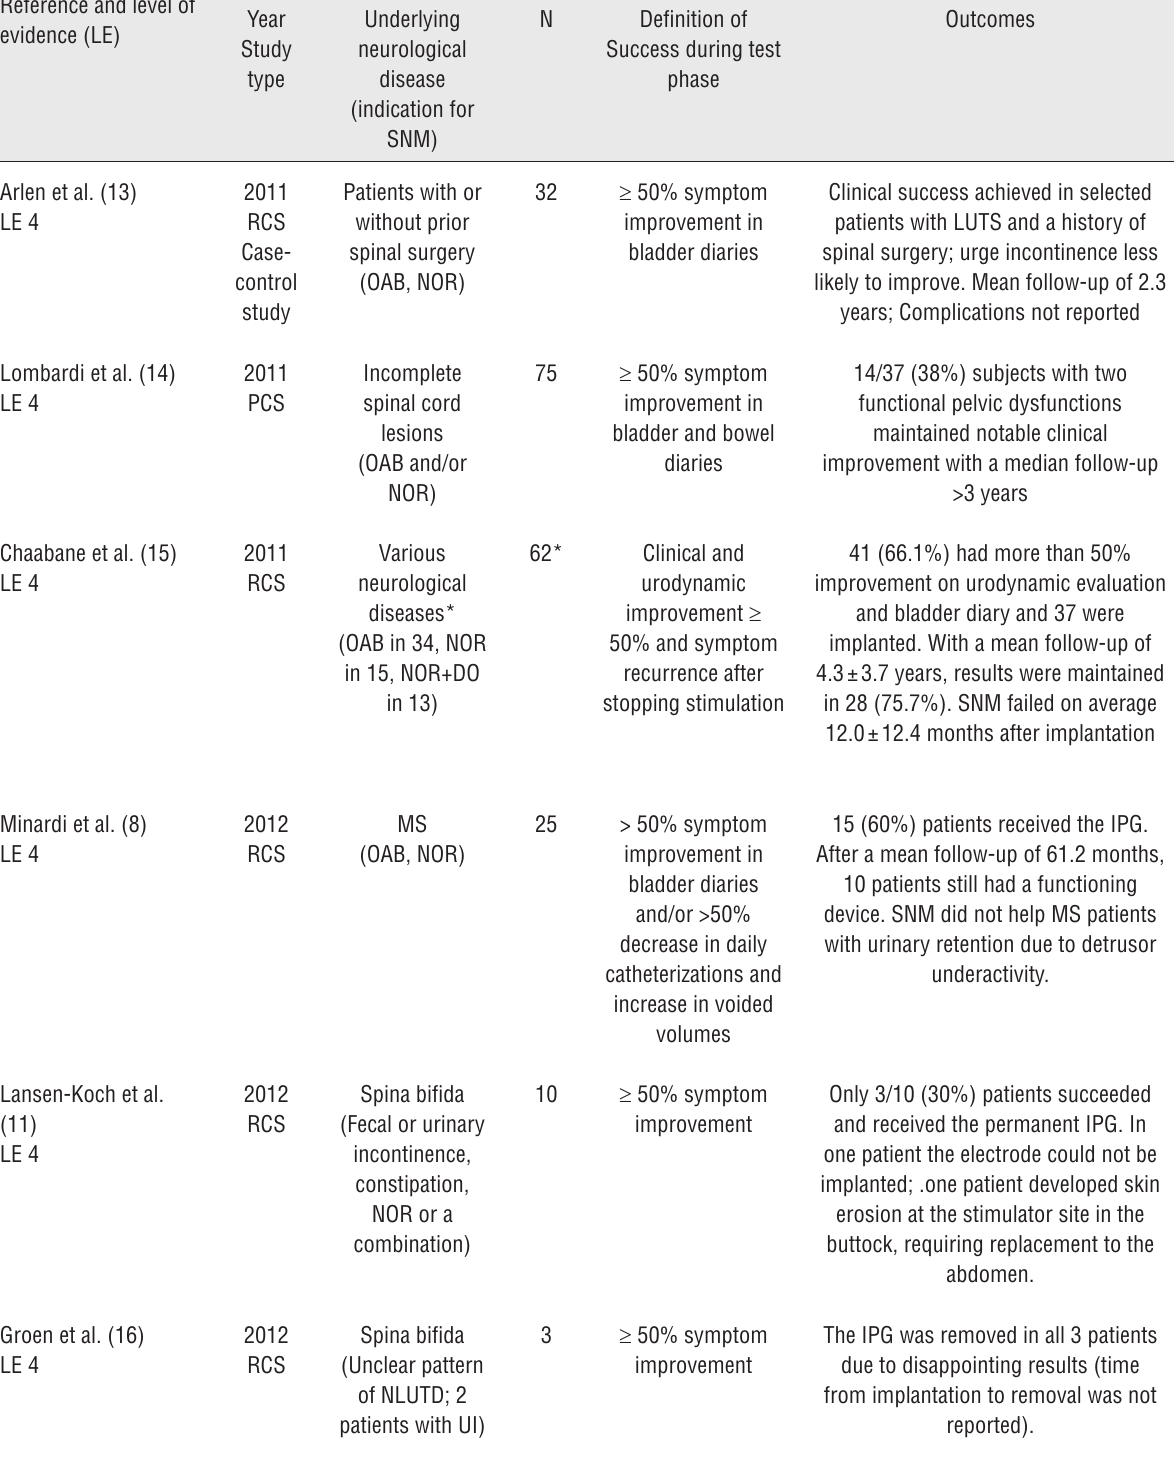
Table 1 - Studies on SNM for NLUTD (published from 2011 to 2019). Reference and level